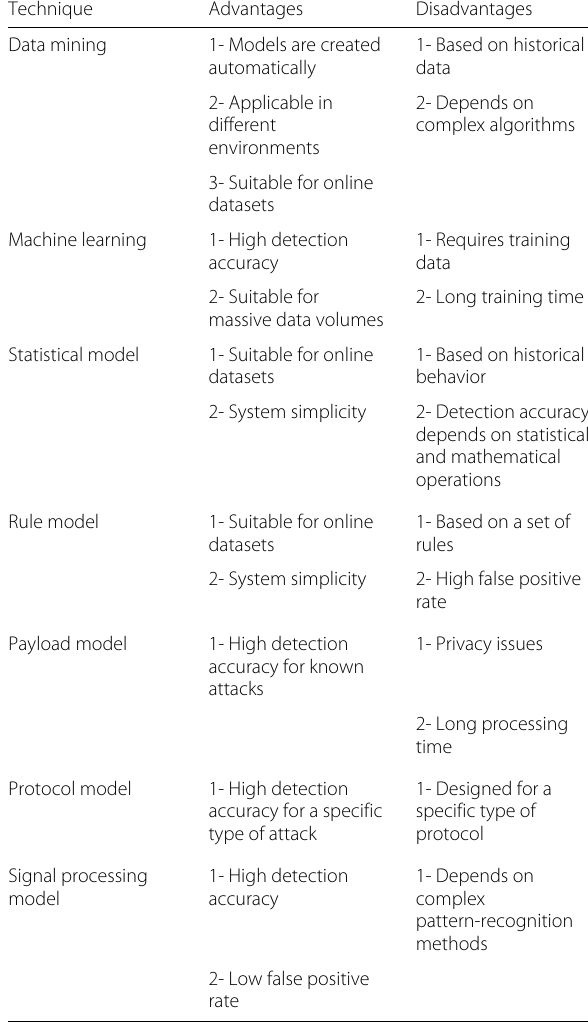
Table 1 A short comparison between anomaly IDS techniques with a focus on the advantages and disadvantages of each technique Technique Advantages